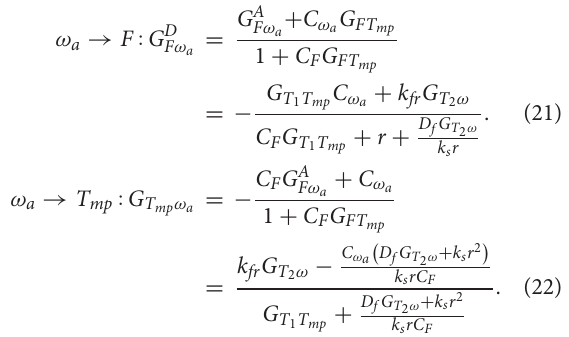
< 1. The control parameters a ω a are a